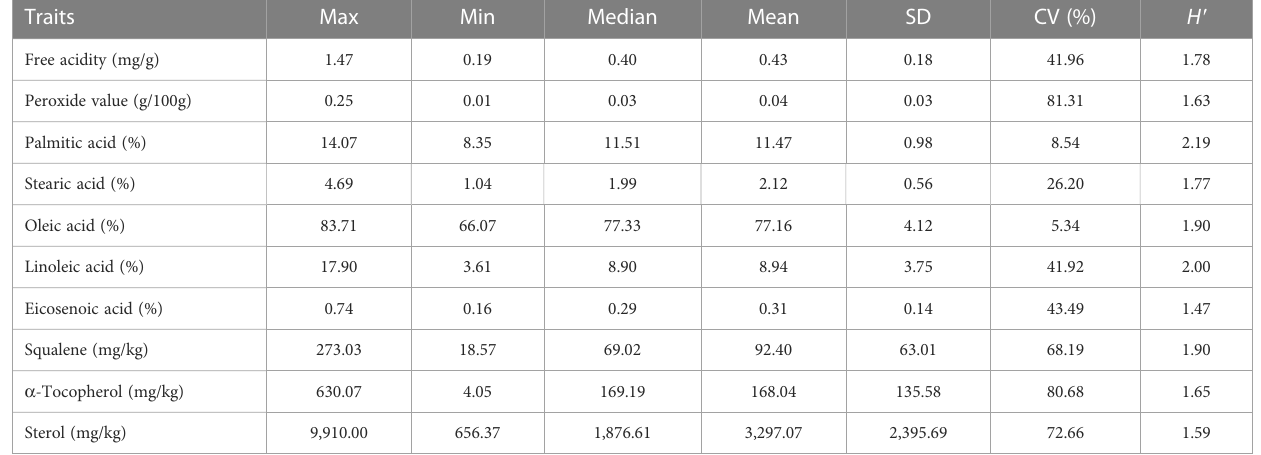
TABLE 3 Fatty acid component and oil quality characteristics for C. oleifera .